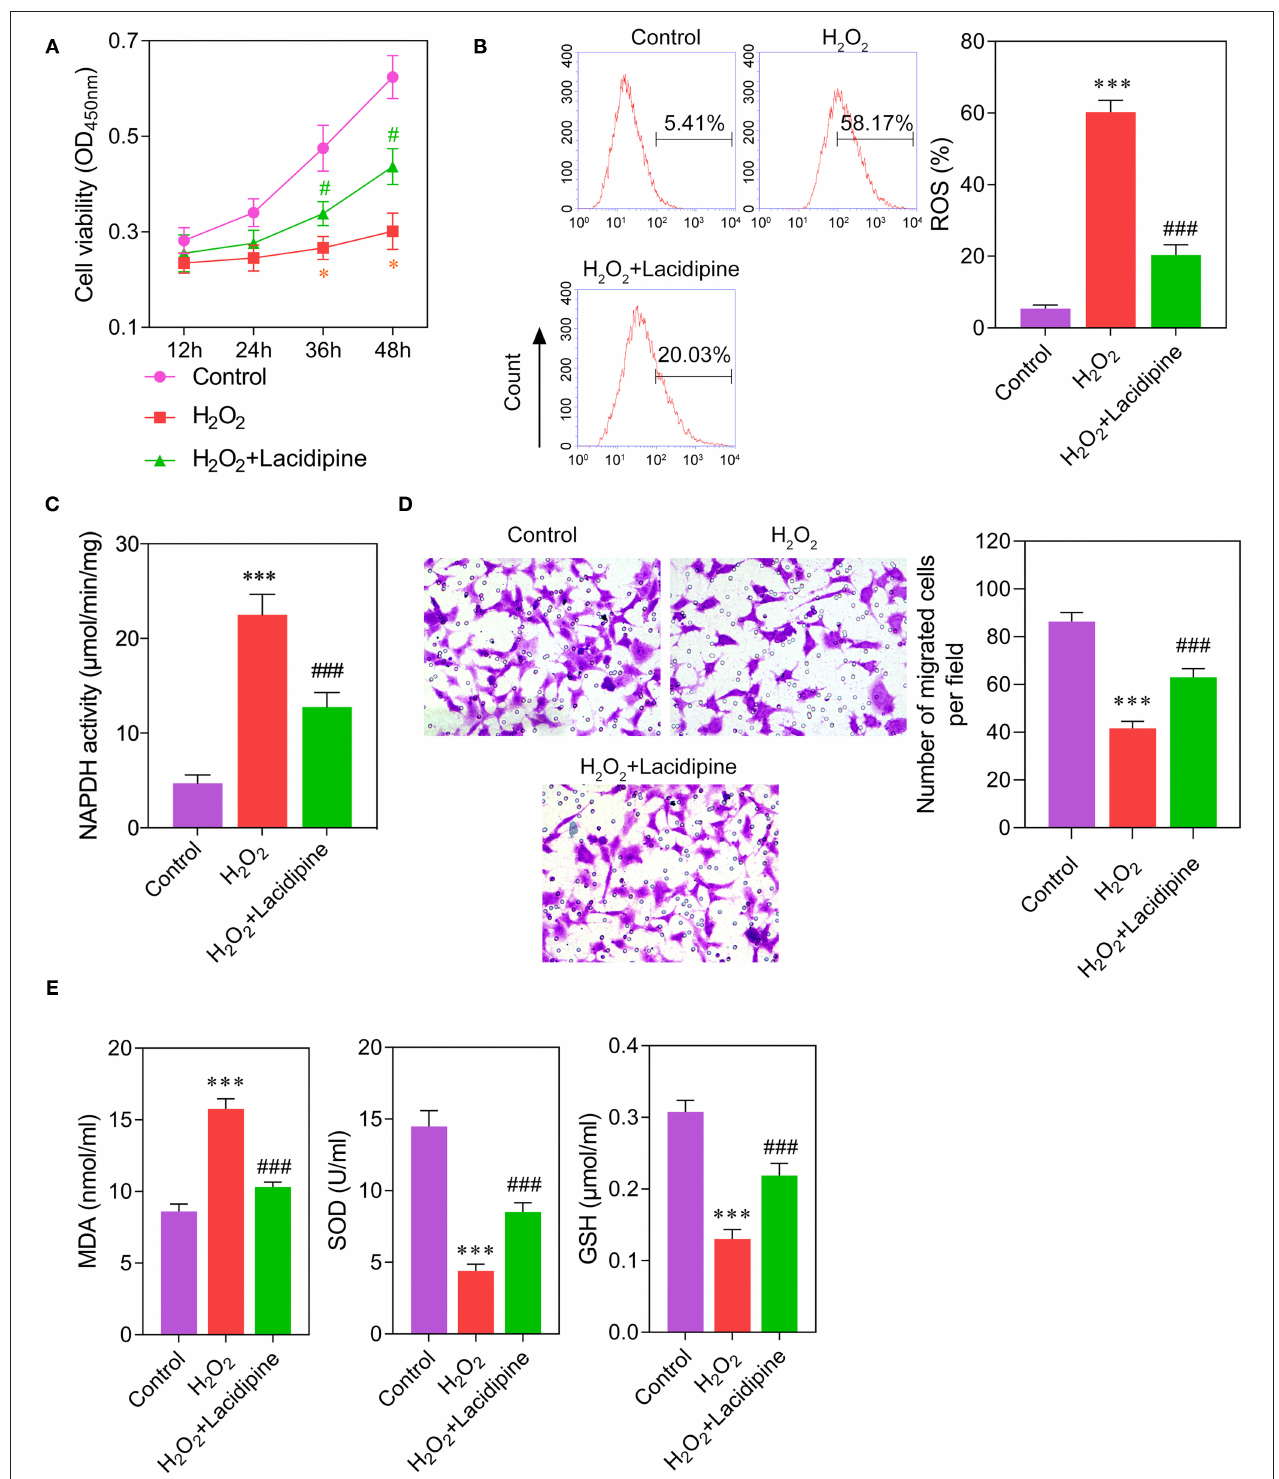
FIGURE 2 | Effects of Lacidipine on the in vitro function of ECs under oxidative stress. Cultured ECs were treated with Lacidipine, followed by H 2 O 2 stimulation (ROS induction). Cell viability was determined using CCK-8 assay (A) . ROS generation was assessed by flow cytometry with 2 ′ ,7 ′ -dichlorofluorescein diacetate (B) . NADPH activity was measured in different groups (C) . Transwell assay was applied to analyze cell migration ability (D) . The levels of MDA, SOD, and GSH in culture supernatant were detected by ELISA assays (E) . (Data are mean ± SD of three independent experiments. * p < 0.05, *** p < 0.001, compared with the control group; # p < 0.05, ### p < 0.001, compared with the H 2 O 2 group).